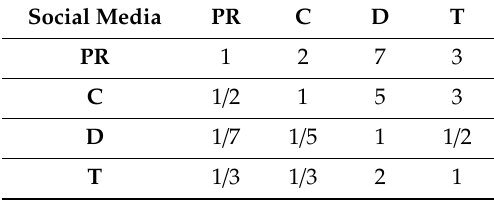
Table 4. The pairwise comparison matrix for the network attributes for social media